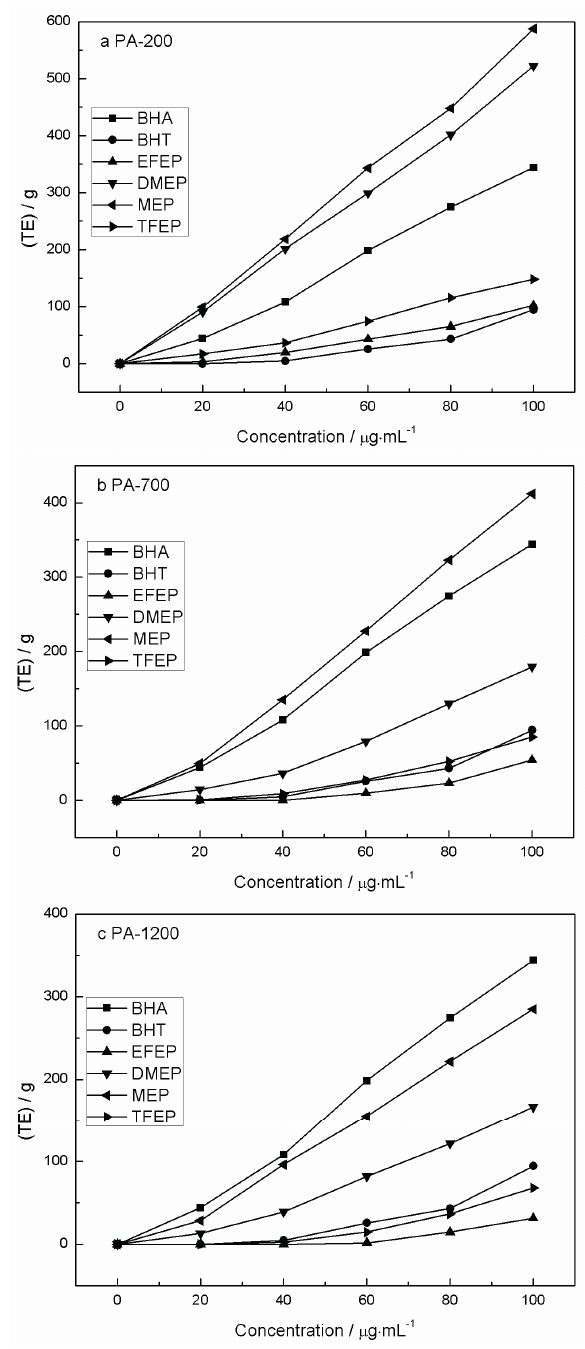
Figure 3. Reducing antioxidant capacities of PA extracts after ( a ) pyrolysis at 200 W; ( b ) pyrolysis at 700 W; ( c ) pyrolysis at 1200